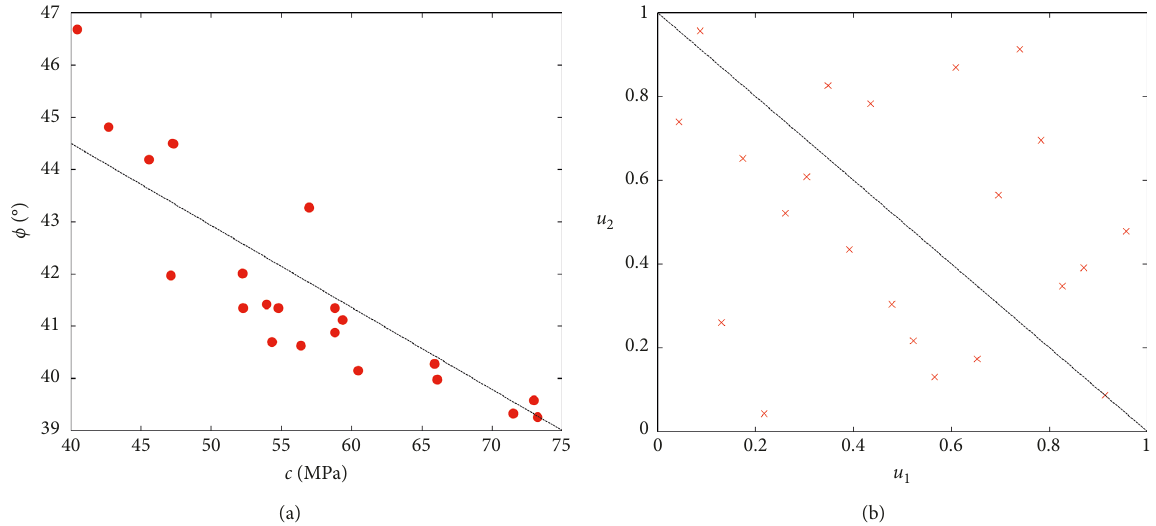
Figure 3: Scatter plots of (a) original data and (b) uniformed